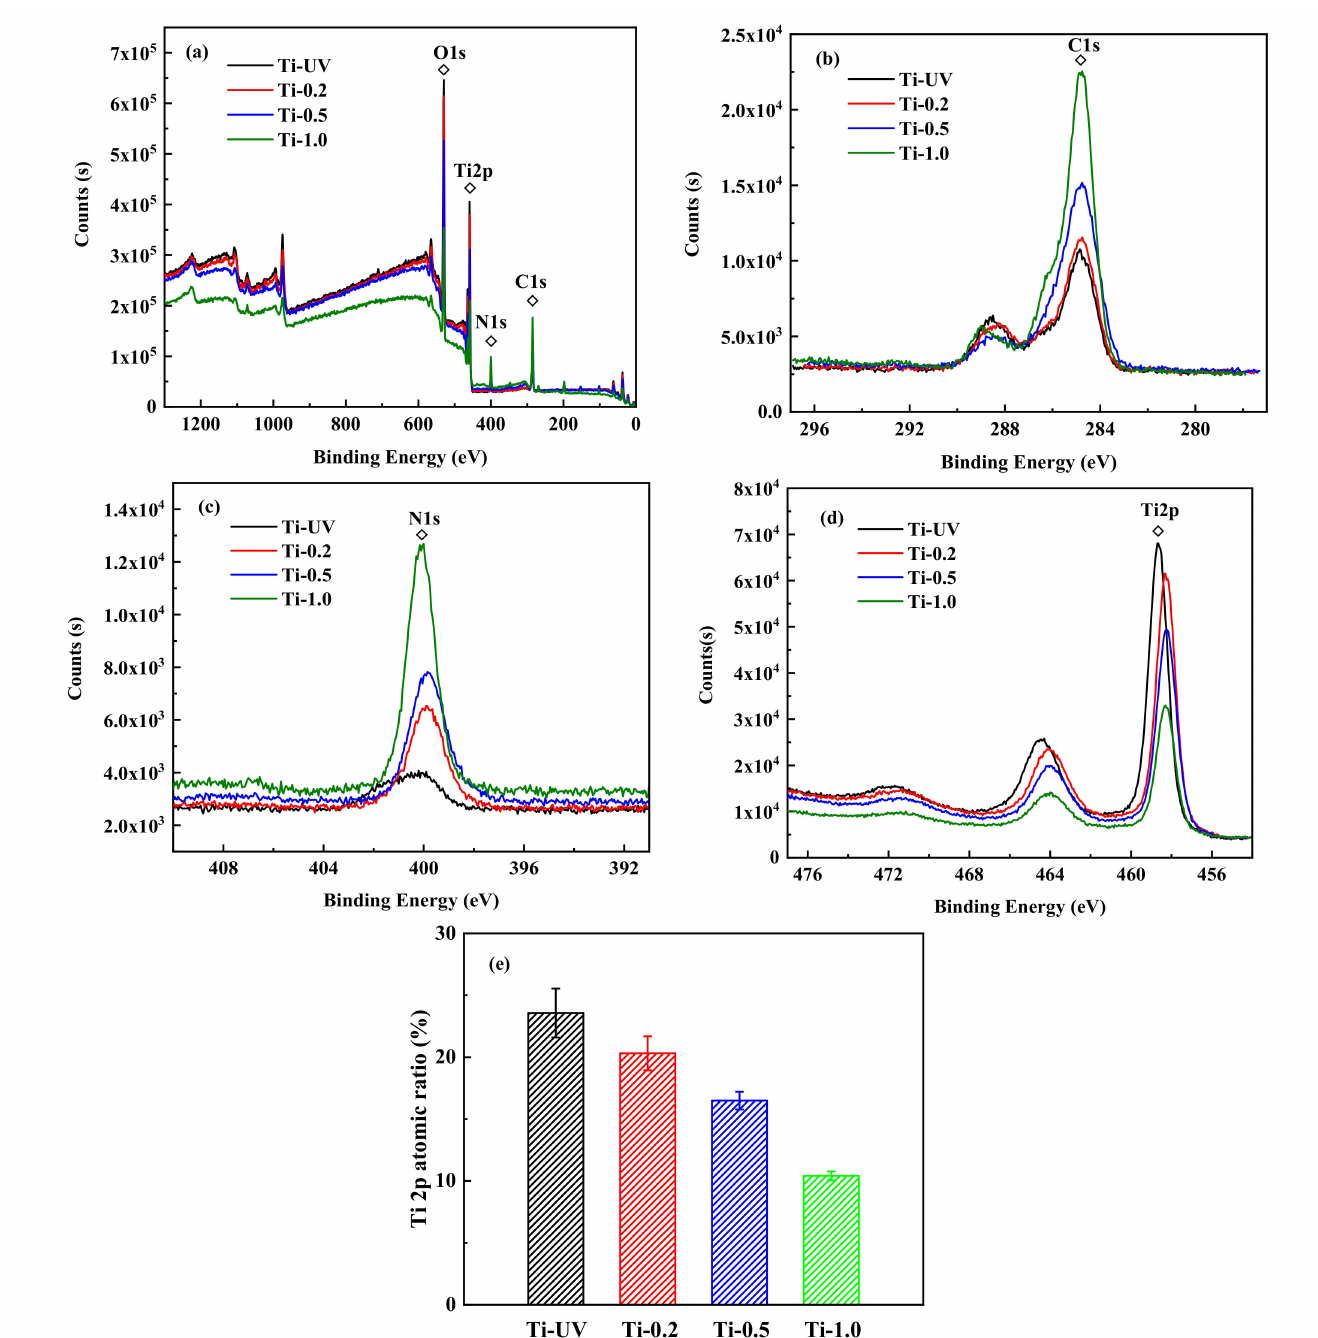
Figure 4. XPS Spectra of Ti samples modified with different concentrations of PHMB ( a ), XPS Spectra of C1s ( b ), N1s ( c ), Ti2p ( d ), and variation of the surface atomic ratio of the Ti ( e